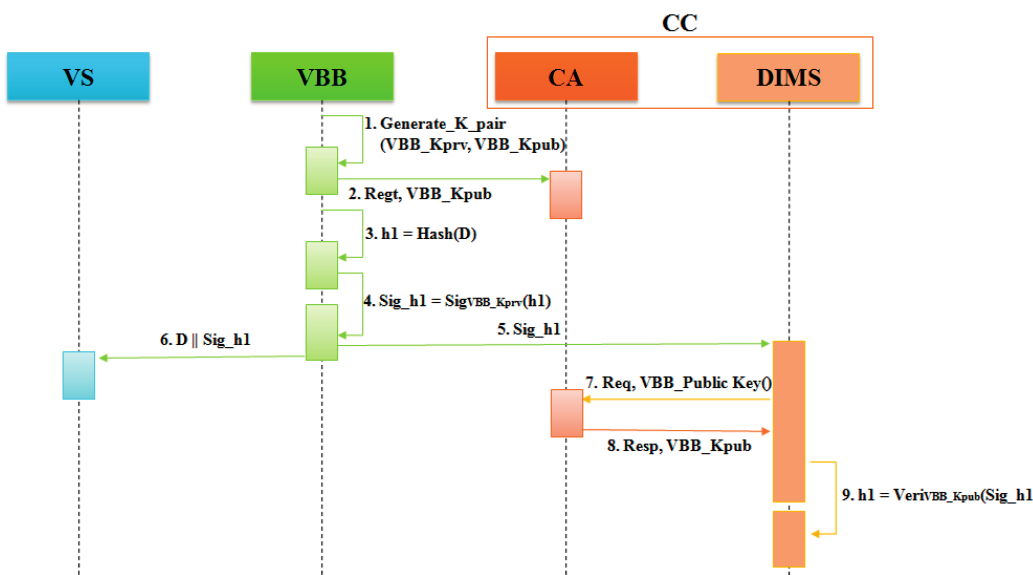
Figure 3. The VBSM’s general